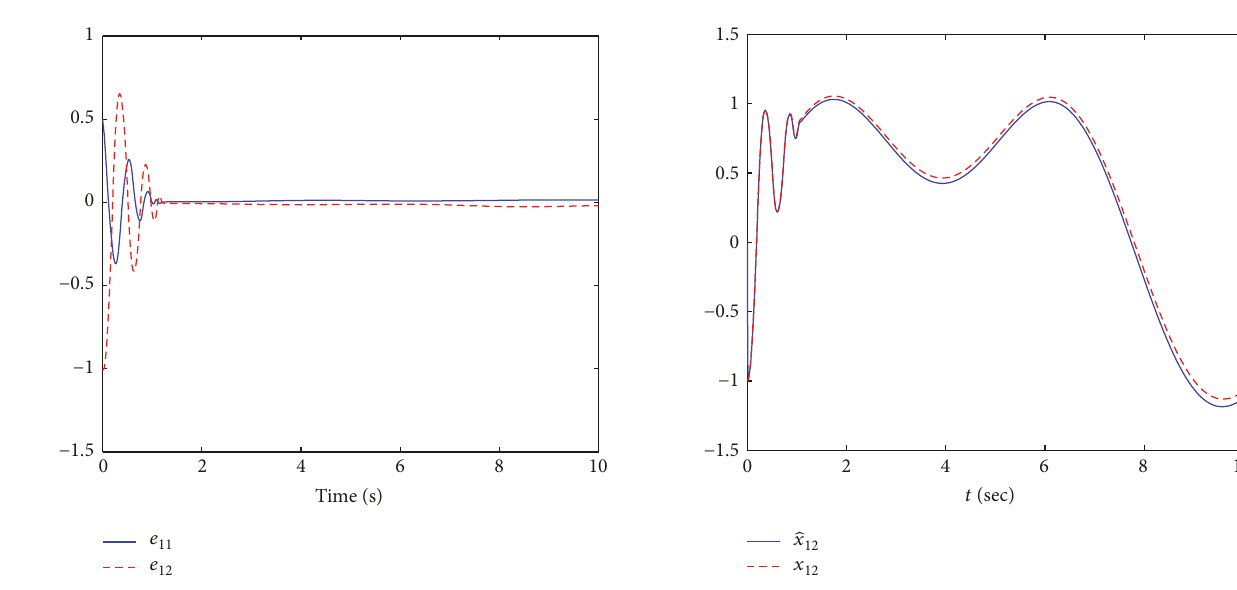
Figure 3: Tracking errors to the two desired trajectories 𝑥 11𝑑 and 𝑥